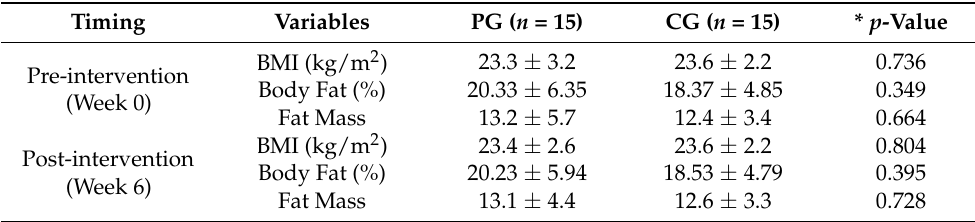
Table 3. Comparison of body composition between PG and CG at pre- and post-intervention.